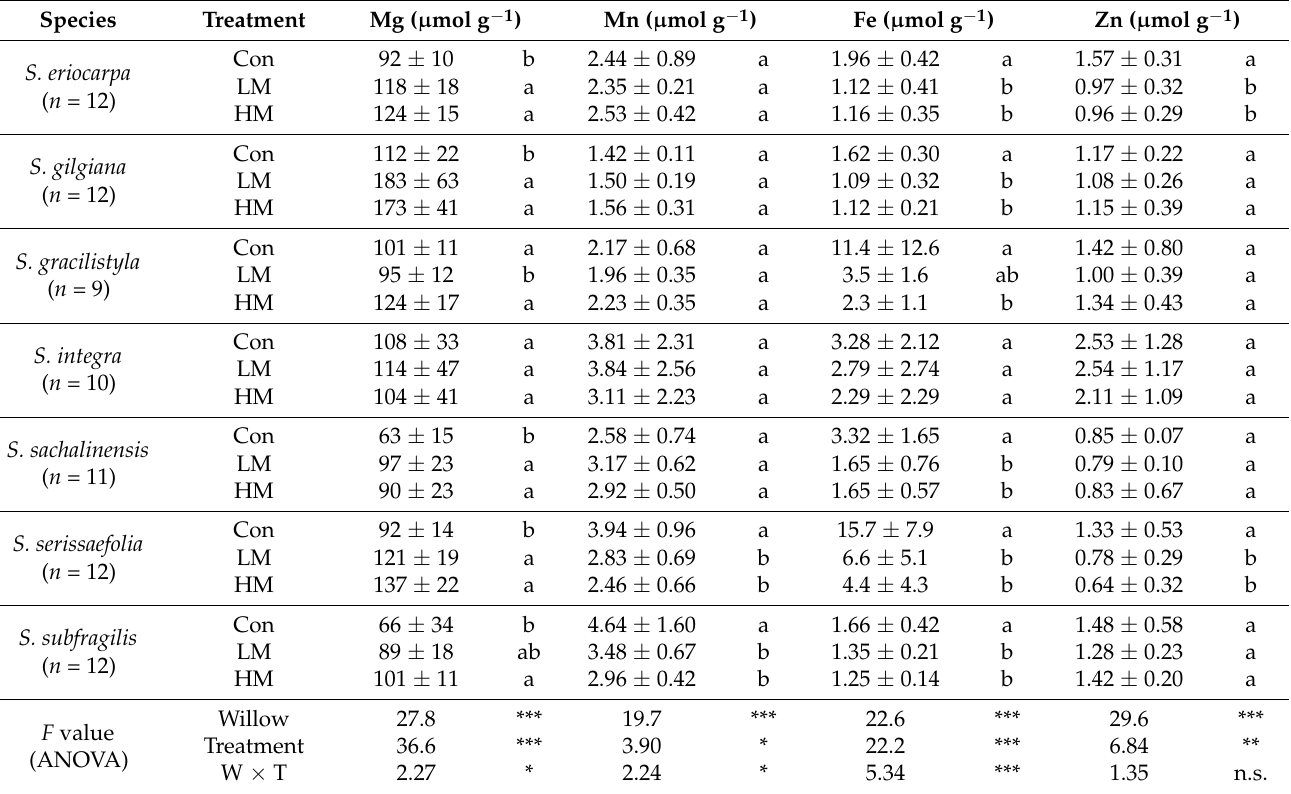
Table 7. Concentrations of chemical elements Mg, Mn, Fe and Zn (dry mass) in the leaves of indi- viduals of seven willows grown under three treatments (mean ± SD). Asterisks indicate significant differences among seven willows, three treatments, and their interaction (W × T) calculated